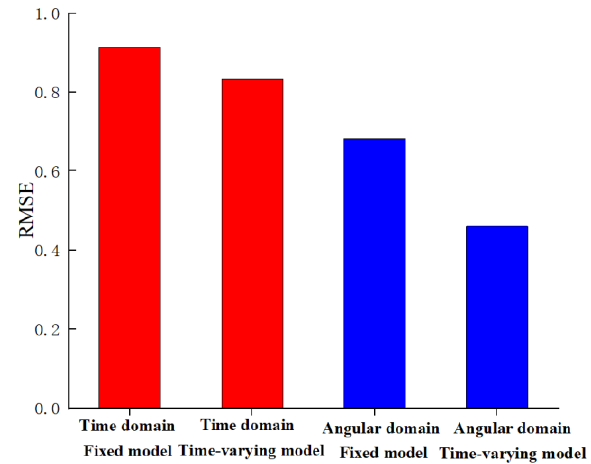
Figure 12. RMSE predicted by four methods.